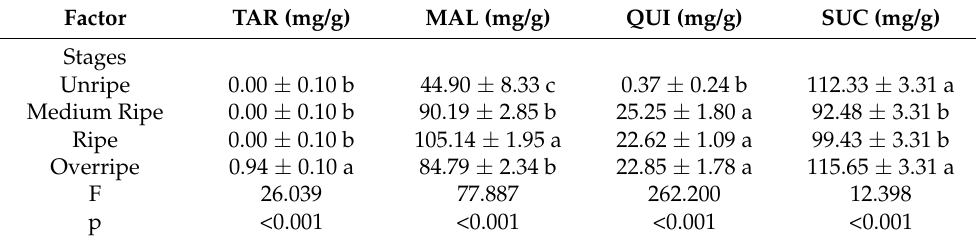
Table 1. ANOVA for tartaric acid (TAR), malic acid (MAL), quinic acid (QUI), and succinic acid (SUC) expressed in dry weight and considering the four development stages of H. edulis “ubajay” harvested from the plants growing in Moreno (Buenos Aires). Values represent means ± standard